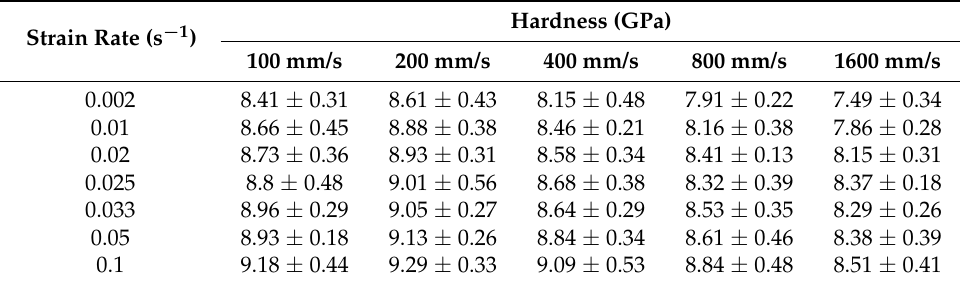
Figure 3. ( a ) An example of typical load-depth curves and ( b ) depth-time curves of SLM H13 samples at various loading rates. Table 1. Hardness values of H13 prepared by the SLM process at various scan speeds.